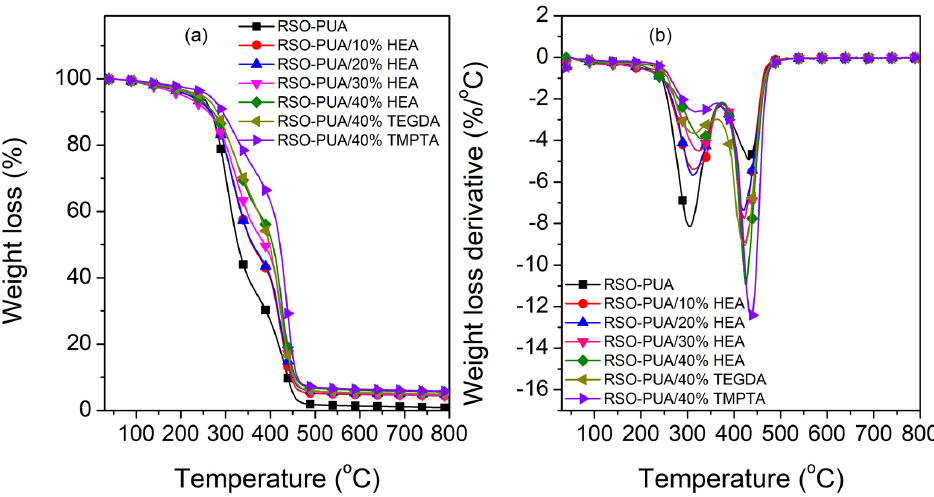
Figure 4. ( a ) TG and ( b ) DTG of the UV-cured RSO-PUA